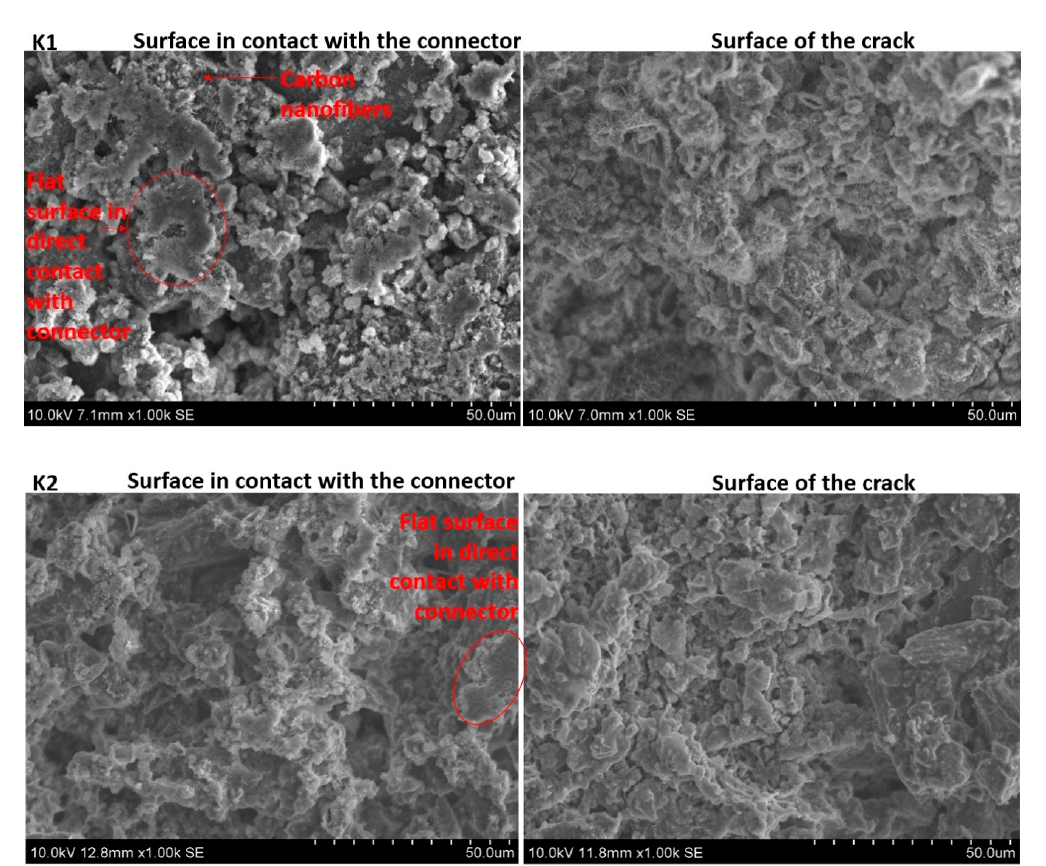
Figure 5. SEM (SE) images showing topography of K1 ( top ) and K2 ( bottom ) surface in contact with steel electrode ( left ) and surface of a fracture ( right ).